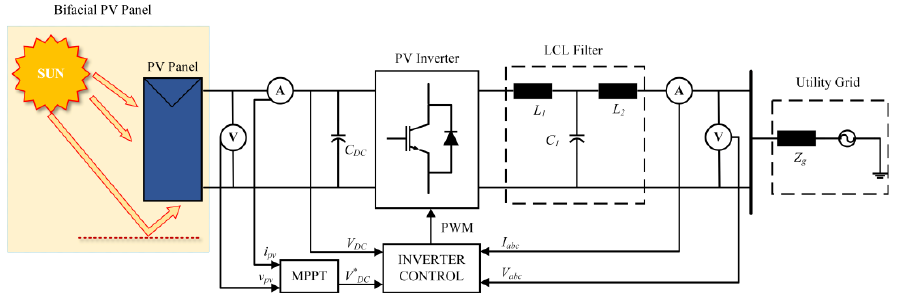
Figure 6. Proposed single phase 3 kW grid connected PV system. Table 2. Parameters of case system.